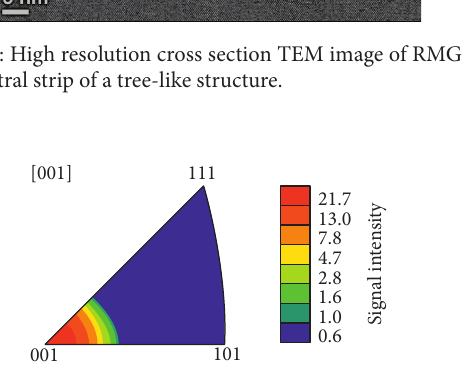
Figure 14: Pole figure of RMG SiGe measured by EBSD. The measured area was approximately 3 𝜇 m × 3 𝜇